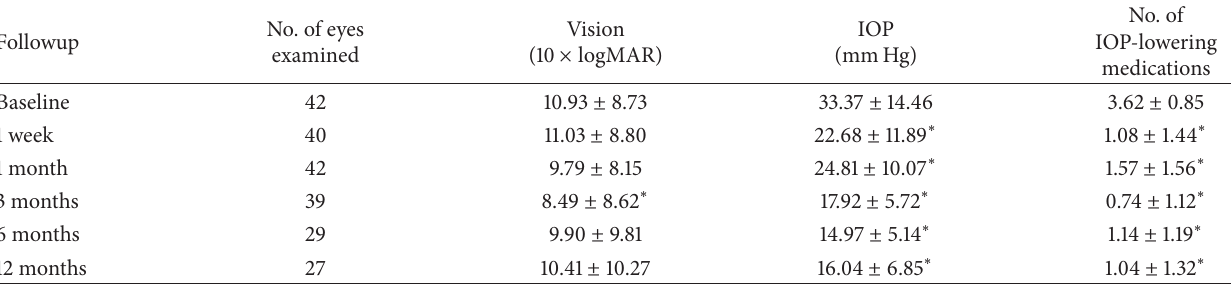
Table 2: Followup vision, IOP, and number of medications.